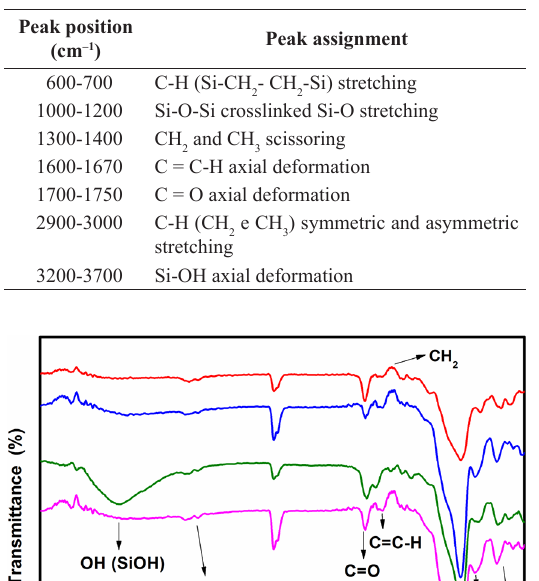
Table 4. FT-IR, peak assignment in relation to peak